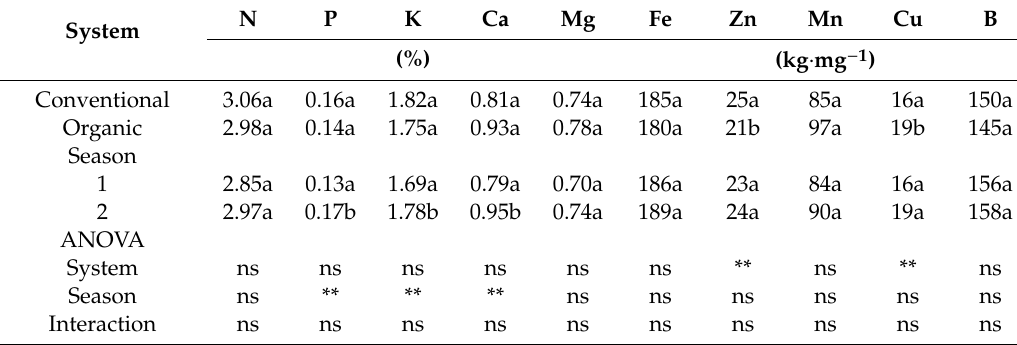
Table 3. Average macro- and micro-nutrient leaf content under conventional and organic systems.